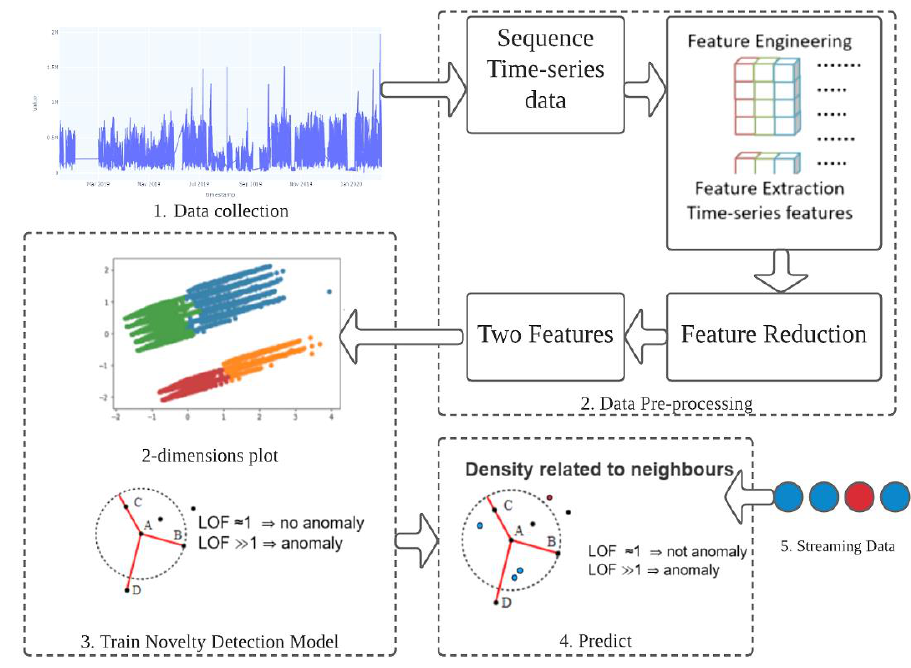
Figure 2. The overall process of the system developed.